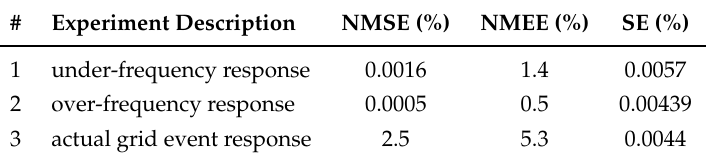
Table 3. Power/frequency control verification experiment: comparison of simulation and experimental results.